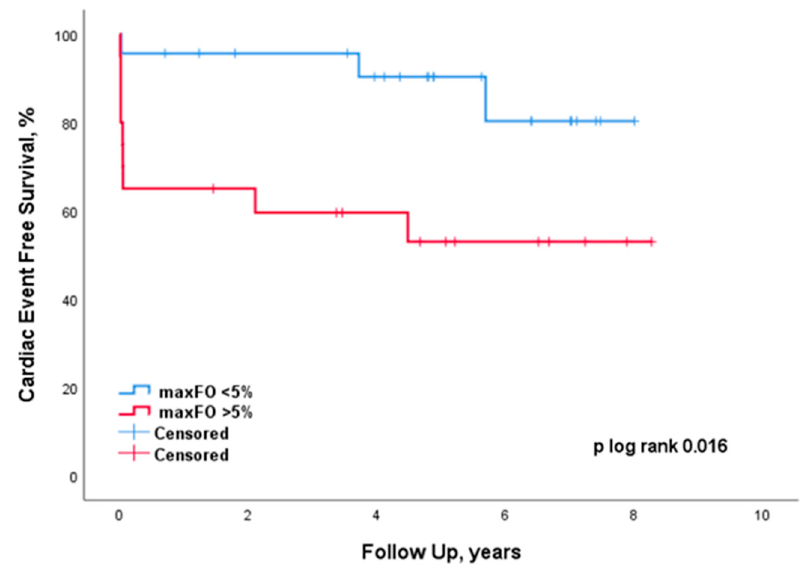
Figure 1. Development of cardiac events according to maximum percentage of